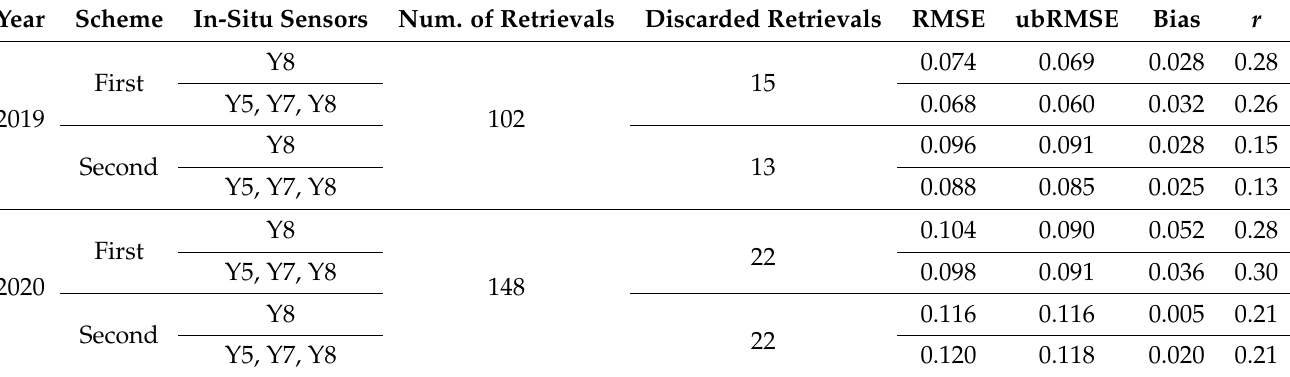
Table 2. Performance of soil moisture retrievals from CYGNSS DDMs. In-situ sensors are the sensors that their measurements used in calculating the performance metrics. All soil moisture values are in unit of m 3 /m 3